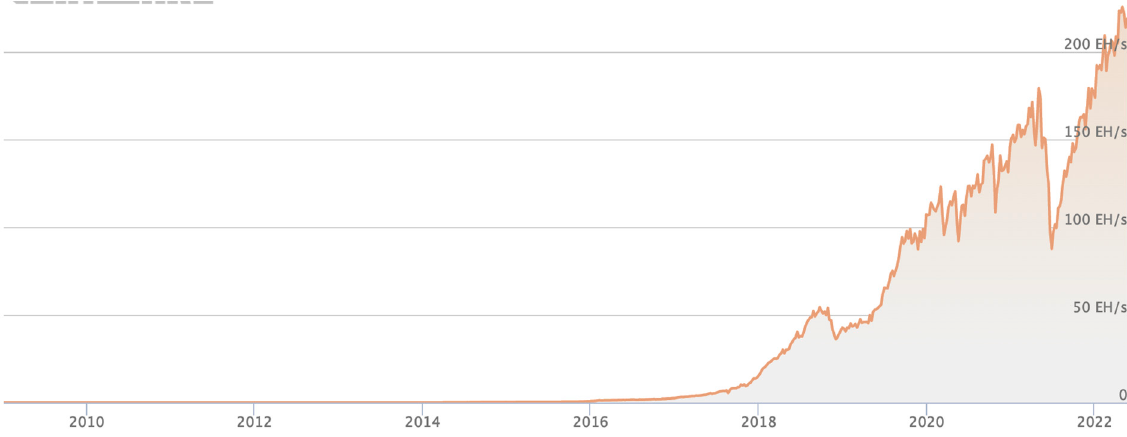
Figure 3. Historical trend of world total hash rate [48].